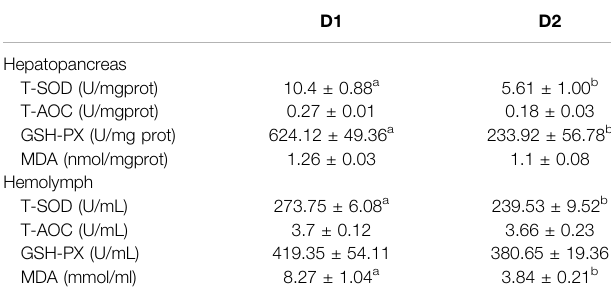
TABLE 4 | Hepatopancreas and hemolymph antioxidant status parameters of L. vannamei fed diet supplemented with/without H. pluvialis GXU-A23 for 56